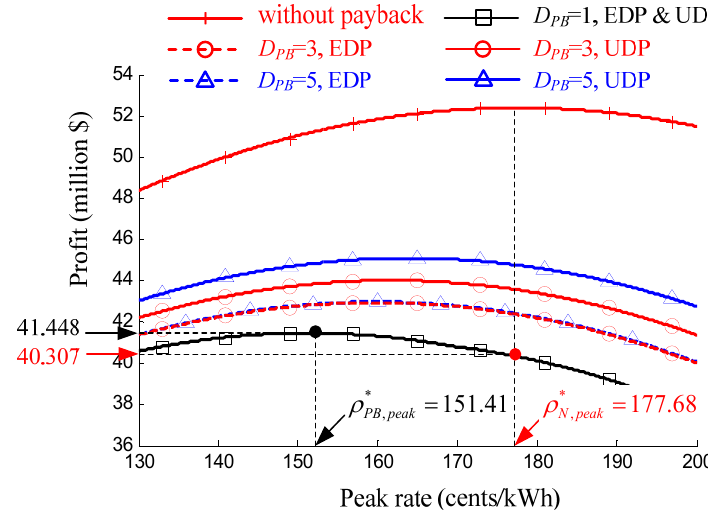
Figure 6. Profit of the load serving entities (LSE) with respect to the peak rate for the case without payback and several cases with